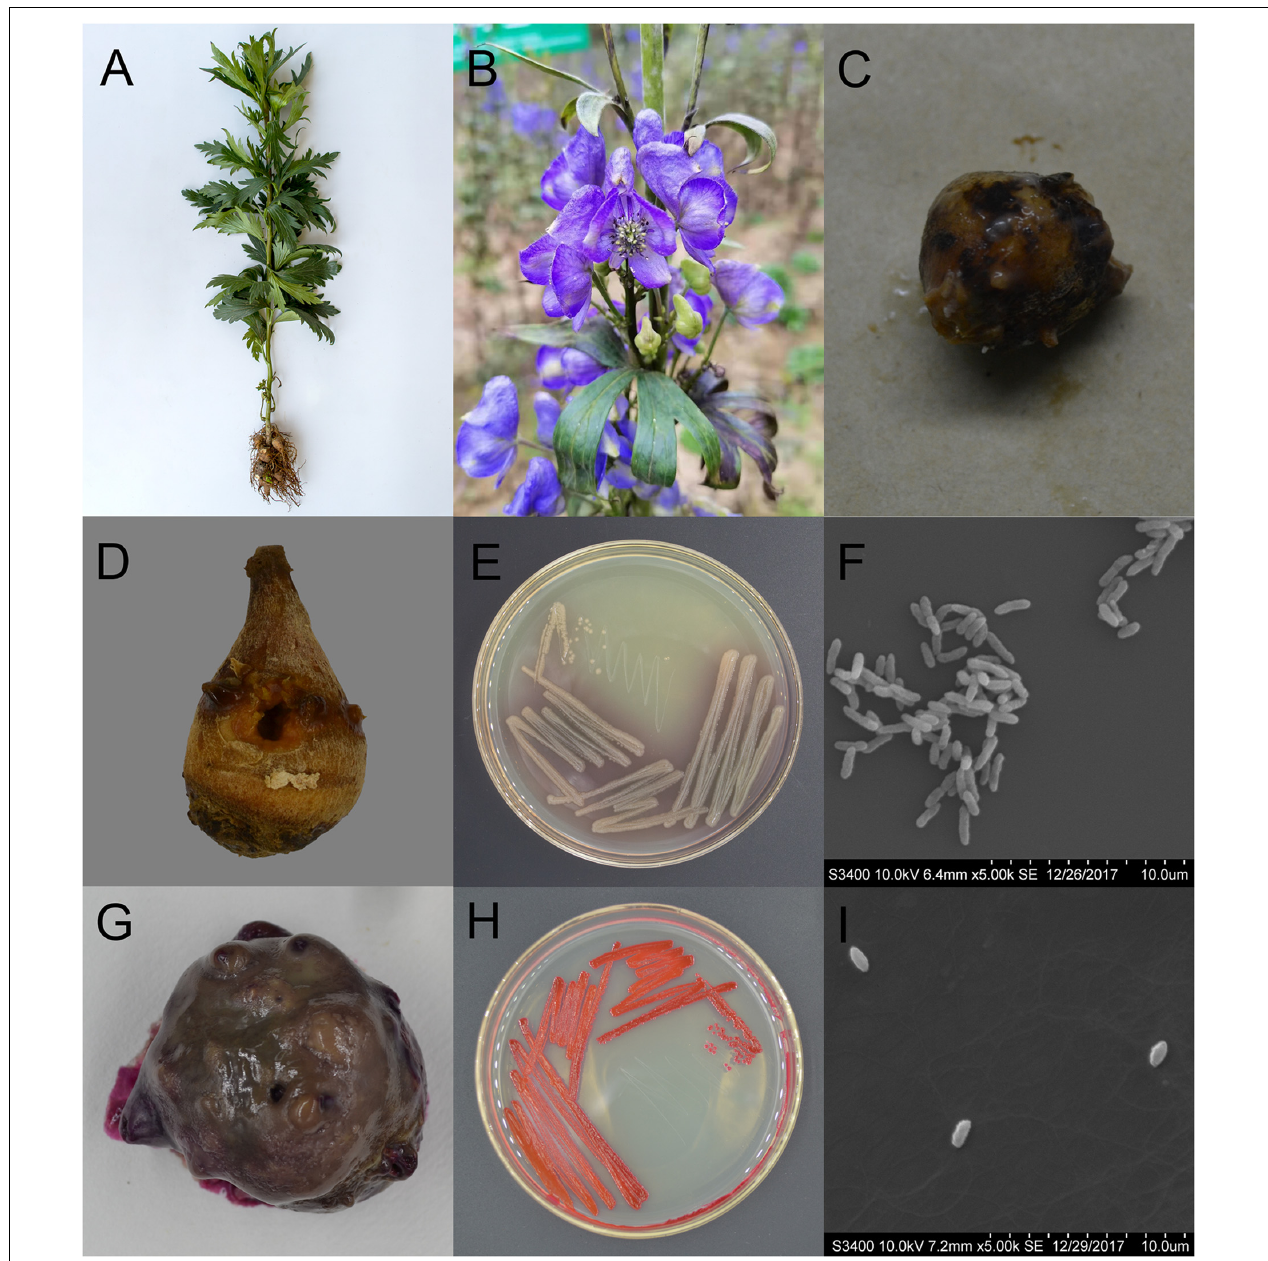
FIGURE 1 | Characteristics of Aconitum carmichaelii and the two isolated pathogens, Pseudomonas aeruginosa and Serratia marcescens. (A) Aconitum carmichaelii cultivars. (B) Aconitum carmichaelii flower. (C) Rotten Fuzi under natural conditions. (D) Rotten Fuzi inoculated with Pseudomonas aeruginosa X1. (E) The morphology of Pseudomonas aeruginosa X1 colonies on KB agar medium. (F) Cell of Pseudomonas aeruginosa X1 as observed by SEM at a magnification of × 5,000. (G) Rotten Fuzi inoculated with Serratia marcescens X2. (H) The morphology of Serratia marcescens X2 colonies on LB agar medium. (I) Cell of Serratia marcescens X2 as observed by SEM at a magnification of ×